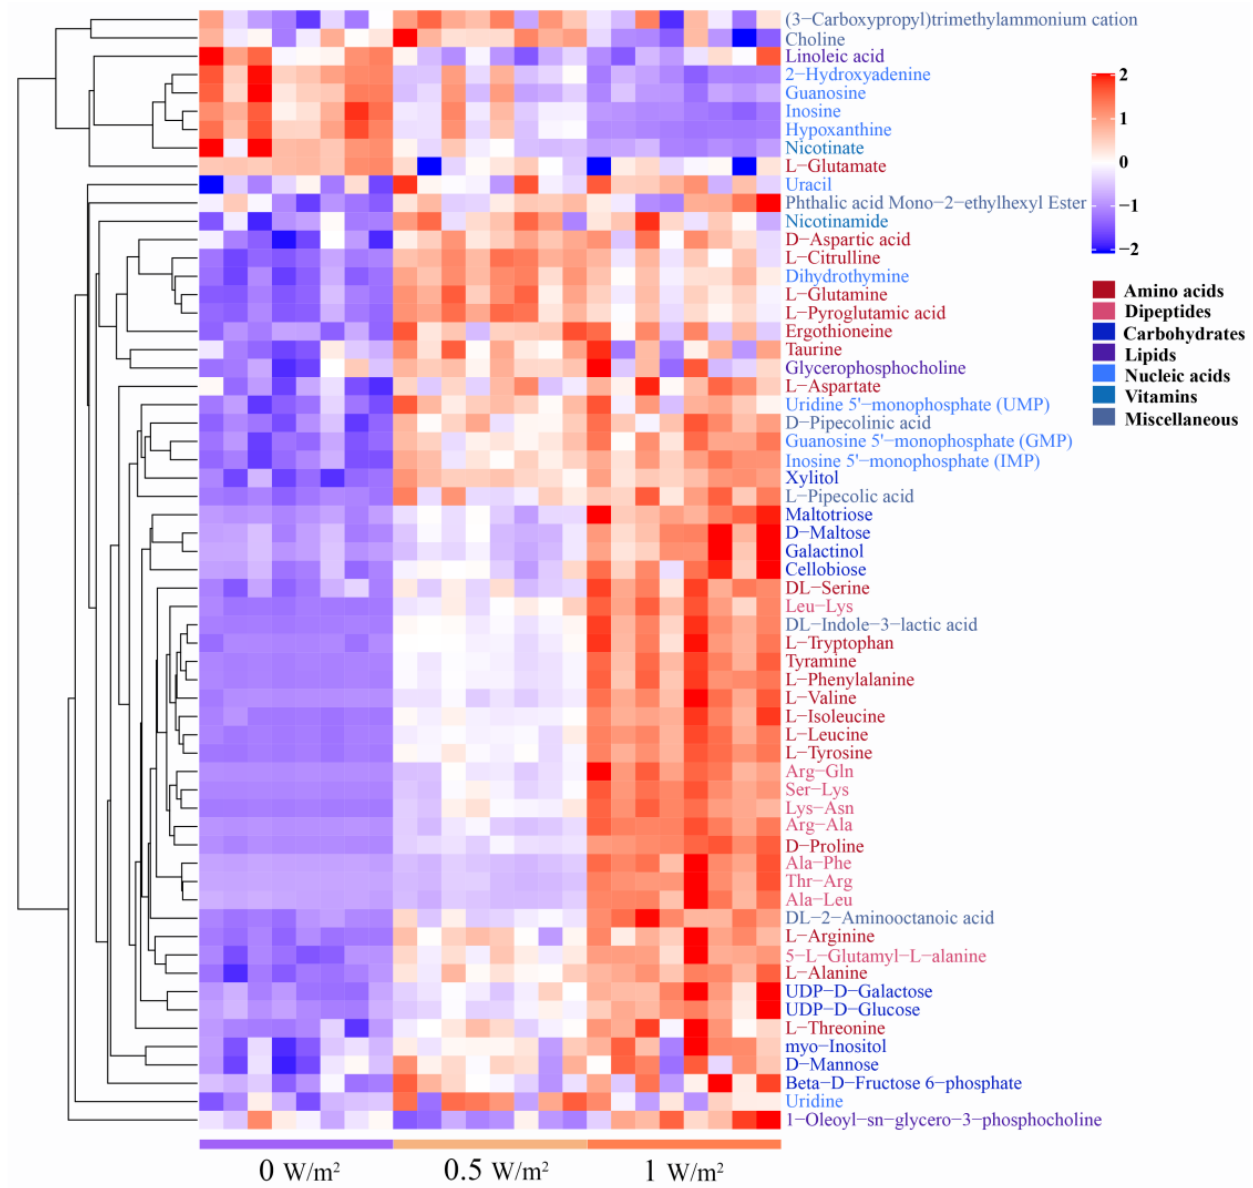
Figure 4. Clustering analysis of differential metabolites of Porphyra haitanensis under different UV-B radiation intensities. Rows and columns represent metabolites and treatment groups, respectively. The red color indicates a high abundance of a metabolite, whereas the blue color represents a low relative abundance of a metabolite. Name of metabolites are marked in different colors to differentiate chemical taxonomy.